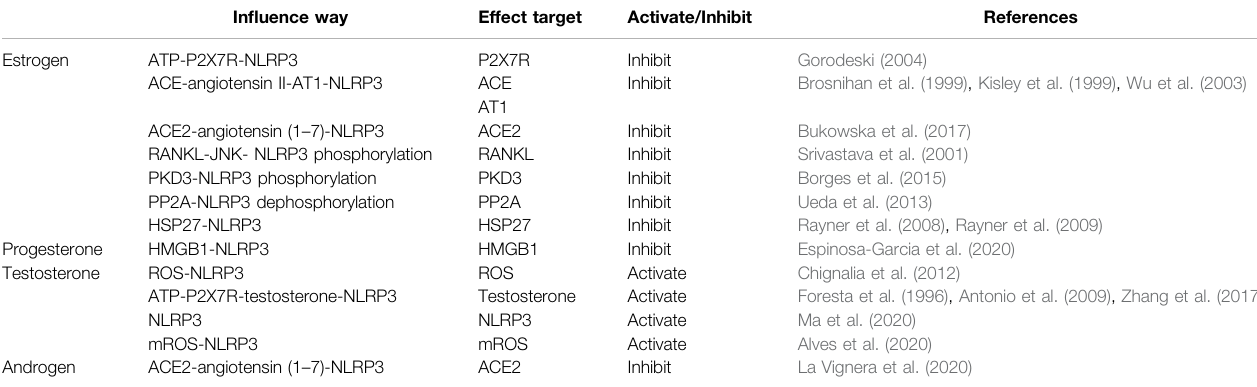
TABLE 1 | Regulatory effects of sex hormones on NLRP3 in fl ammasome activation. In fl uence